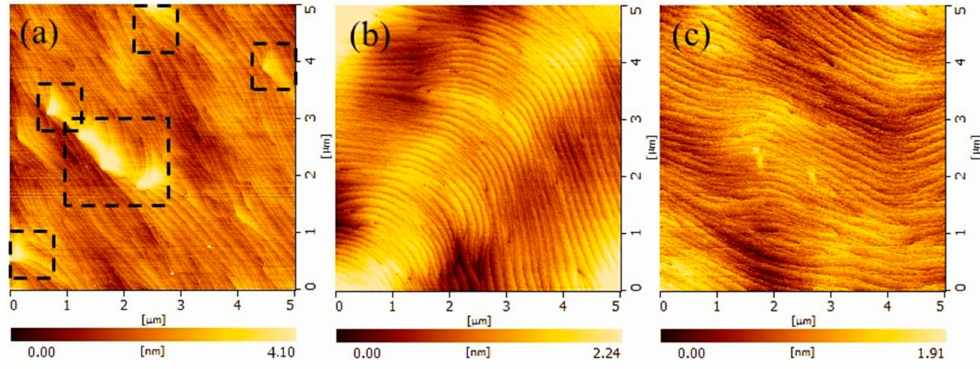
Figure 3. The AFM images (5 µ m × 5 µ m) of bulk GaN with ( a ) 0, ( b ) 2 and ( c ) 4-min annealing time. The black boxes in ( a ) are step kinks.